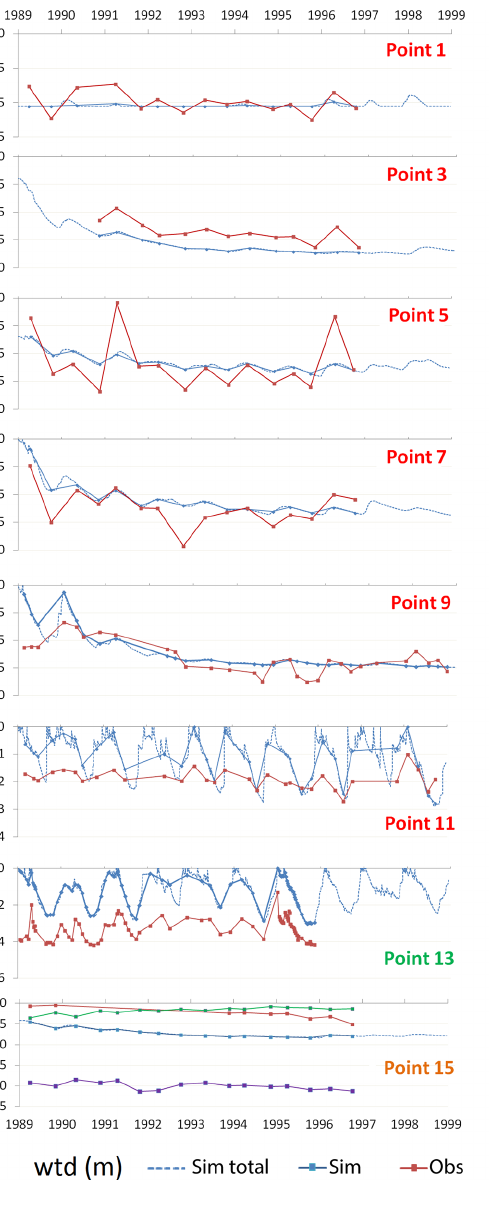
Figure 5. Water table depth (m) time series along the 10-year period at the stations numbered in Fig. 4 (1 to 16): observed (connected red dots), simulated at observation times (connected blue dots), simulated daily (dashed blue line), and observed at the second and third observation points within one model cell (connected green and purple dots,